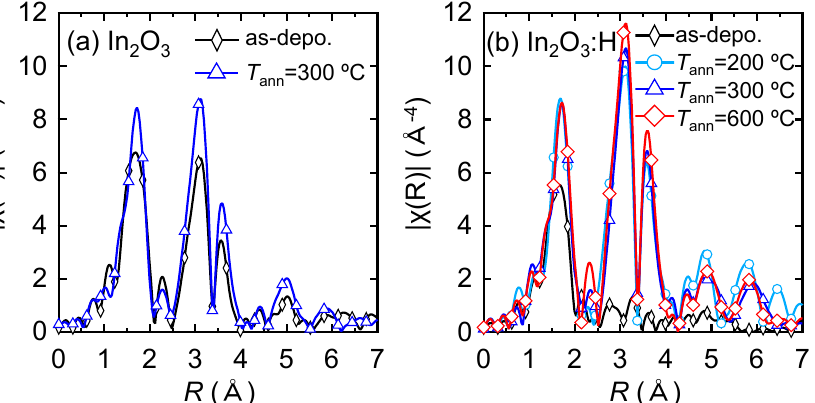
Figure 3. FT EXAFS spectra of the In K-edge for the ( a ) In 2 O 3 and ( b ) In 2 O 3 :H films with various T ann values. Table 1. EXAFS fitting results for first, second, and third shells in the In 2 O 3 and In 2 O 3 :H films.